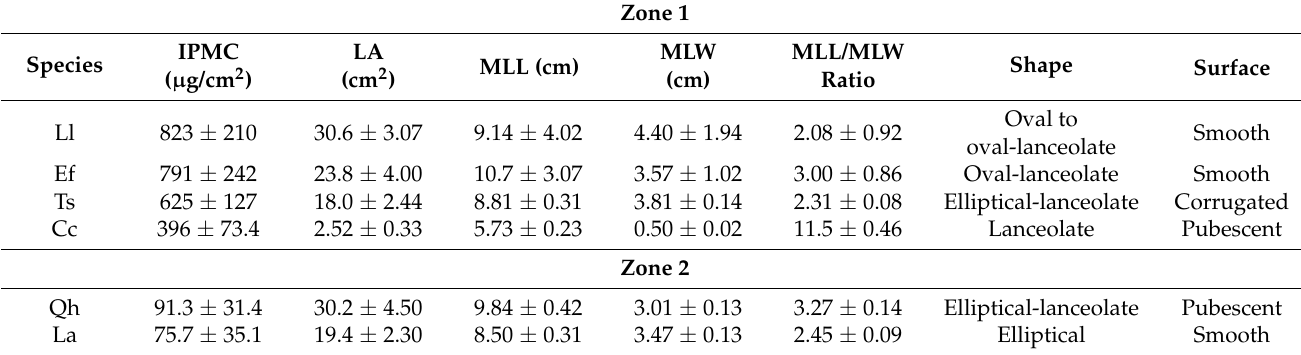
Table 3. Average leaf morphology of the tree species under study. Zone